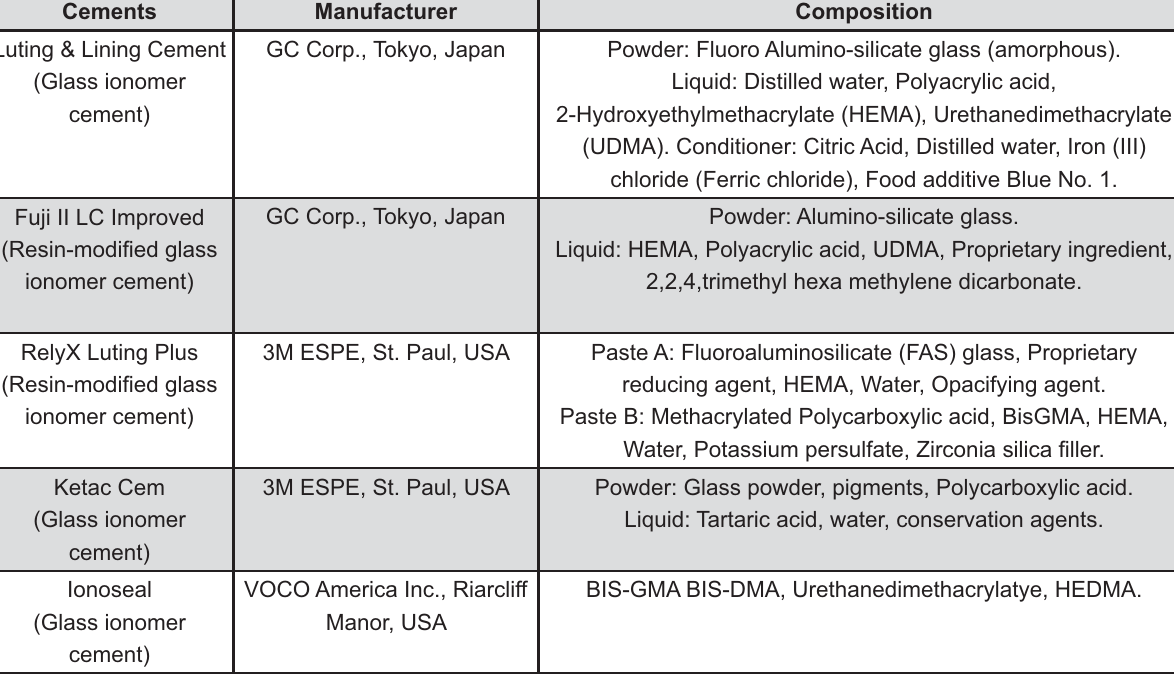
Figure 1- Description of the cements and their chemical